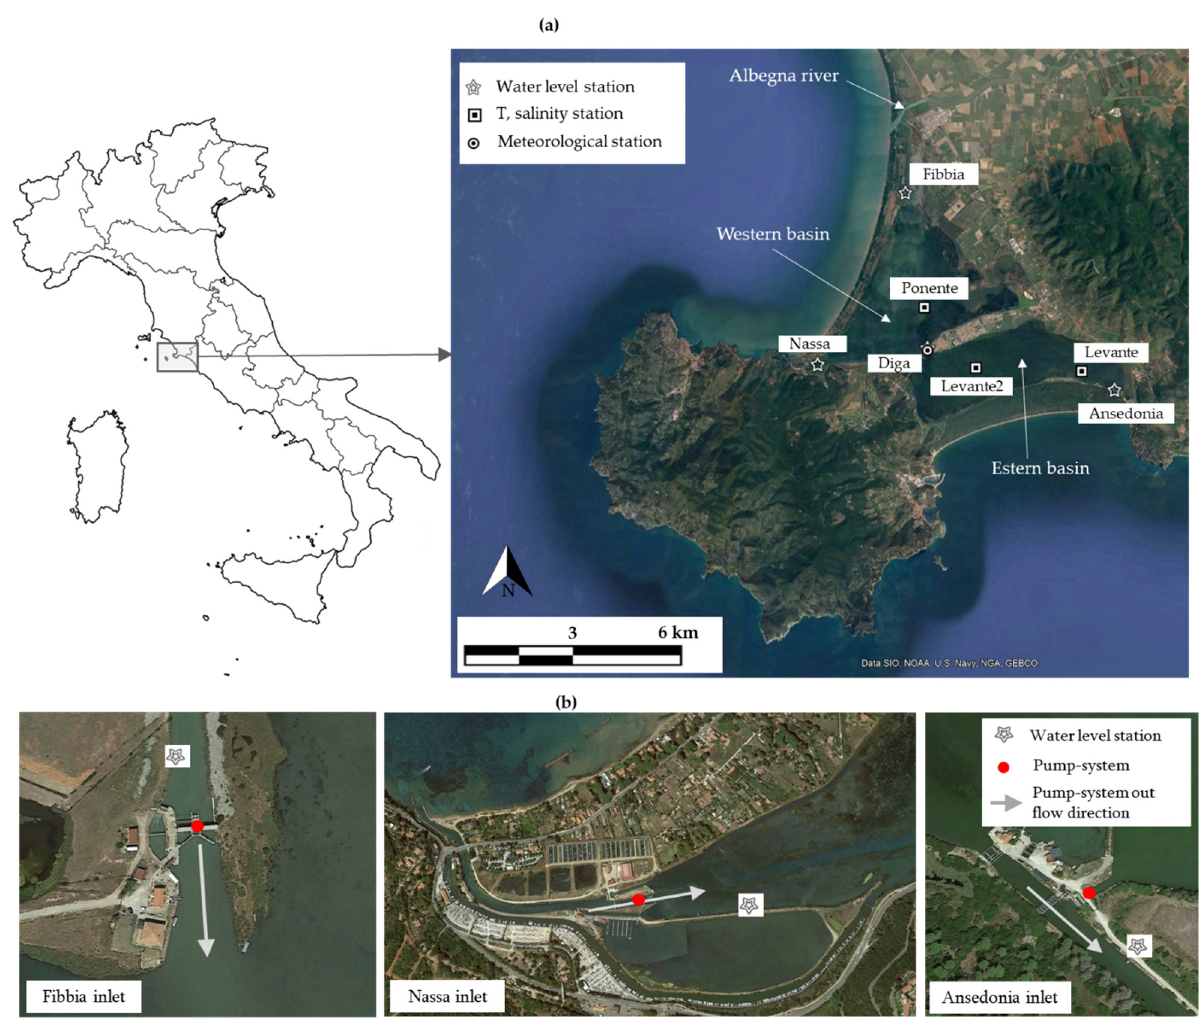
Figure 1. Location of the Orbetello Lagoon and of water level, temperature, salinity, and meteorological stations ( a ). Detail of the lagoon inlets, with the location of the forced water pumping systems and direction of the flow under forced conditions ( b ).